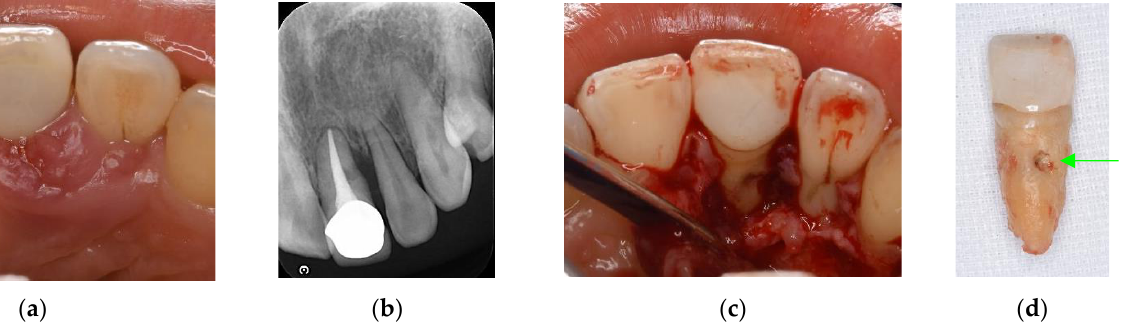
Figure 3. Clinical case 2. Female, age 35 yrs. ( a ) Intraoral view of the left maxillary incisor just before operation. ( b ) Preoperative periapical radiograph, with the “bone” defect presenting as a radiolucent area in both coronal and the middle of the root. ( c ) Flap retraction and debriding of the defect. ( d ) Photo of the extracted tooth, showing external root resorption (arrow).